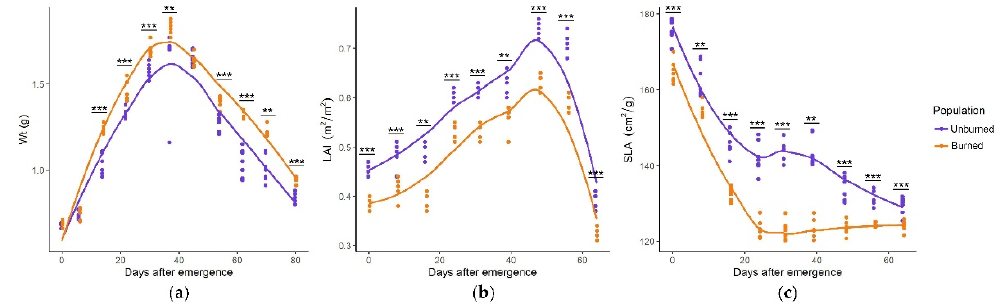
Figure 4. Seasonal dynamics of Wt (total plant weight, g) ( a ), LAI (leaf area index, m 2 /m 2 ) ( b ), and SLA (specific leaf area, cm 2 /g) ( c ) in I. pumila plants from unburned and burned sites. Statistically significant differences are indicated with asterisks, ** p < 0.01, *** p < 0.001.